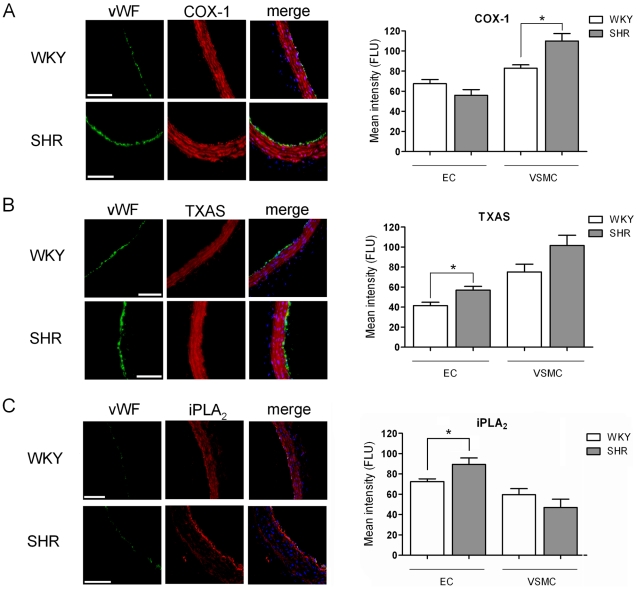
Immunohistochemistry of relevant proteins in SHR carotid artery.A) Immunohistochemical staining (left, typical staining images; 200× magnification) and quantification (right) of SHR or WKY carotid artery segments depicting cell nuclei staining (blue), with/without the von Willebrand Factor (vWF) endothelium marker (green) and cyclooxygenase-1 (COX-1; red). B) thromboxane synthase (TXAS; red) and C) calcium-independent phospholipase A2 (iPLA2; red). Please note the increased EC/VSMC iPLA2 expression ratio in SHR. Data presented as mean ± SEM, n = 5–6, (*) p<0.05, scale bars 100 µm.